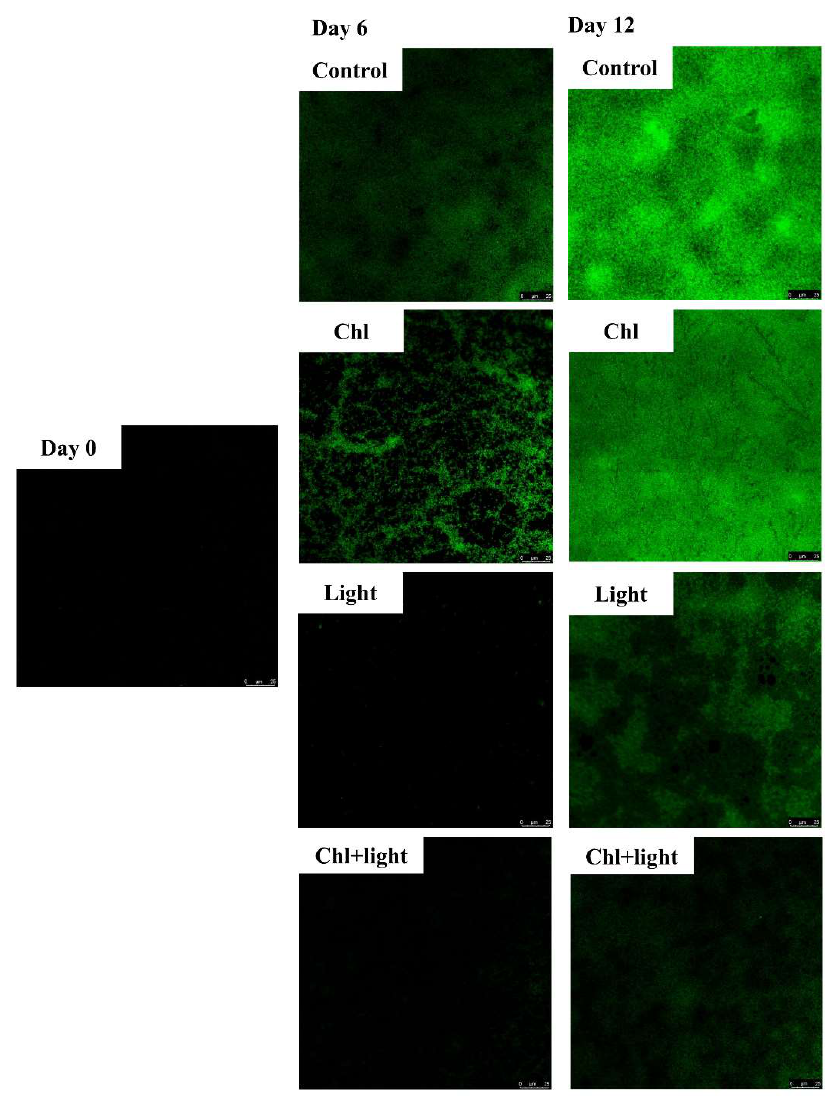
Figure 4. The figures of biofilms’ formation on samples by using CLSM.